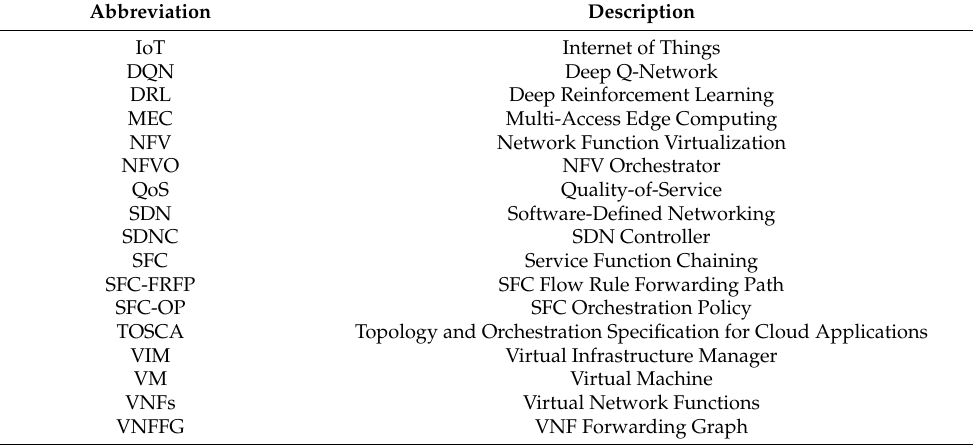
Table 1. List of important